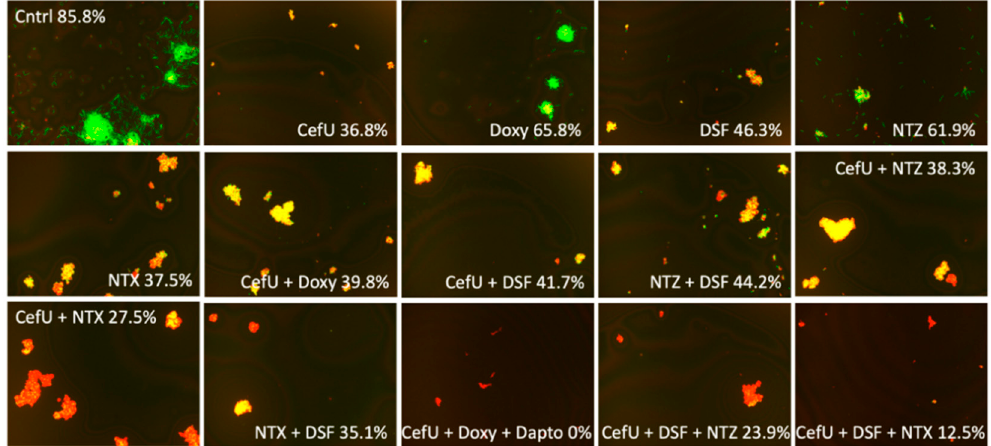
Figure 1. Effect of single drugs, and two-drug and three-drug combinations of interest at Cmax concentration. Abbreviations: untreated control (Cntrl), cefuroxime (CefU), daptomycin (Dapto), doxycycline (Doxy), disulfiram (DSF), doxycycline (Doxy), nitazoxanide (NTZ), nitroxoline (NTX).